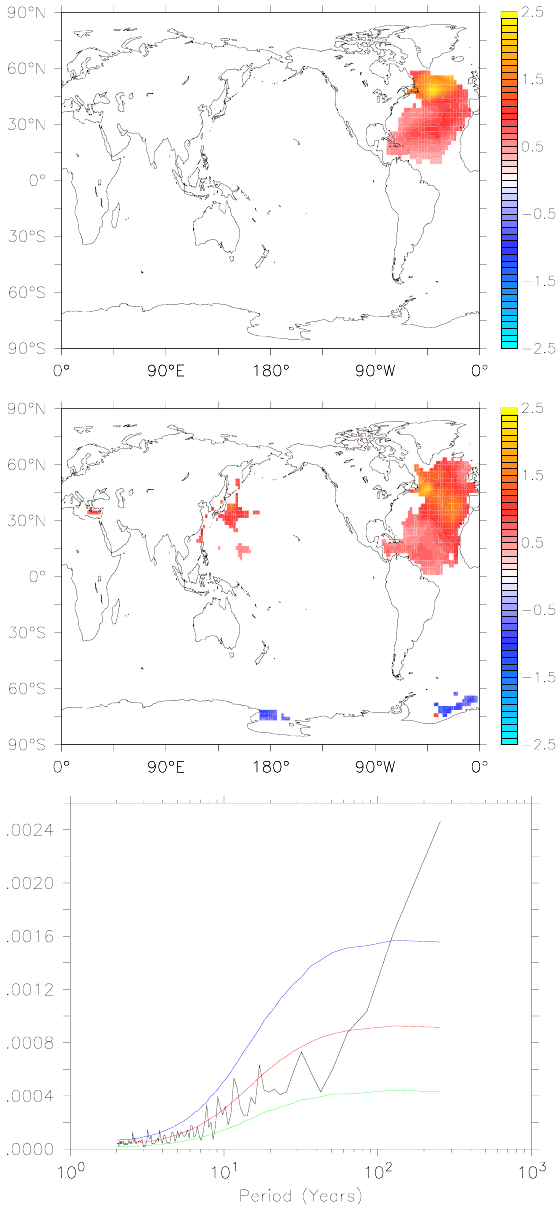
Fig. 14. The regression coefficient of the SST with the AMO index in 10 − 6 Ksm − 3 in SPEEDO (top) and the NCEP-NCAR reanalysis (Kalnay et al., 1996) for the period from 1960 to 2000 (center), and the power spectrum of the AMO index time series in K 2 in SPEEDO (bottom). The simulated AR(1) spectrum (red), and the minimum (green) and maximum (blue) of the 95% confidence interval are also shown in the bottom panel.